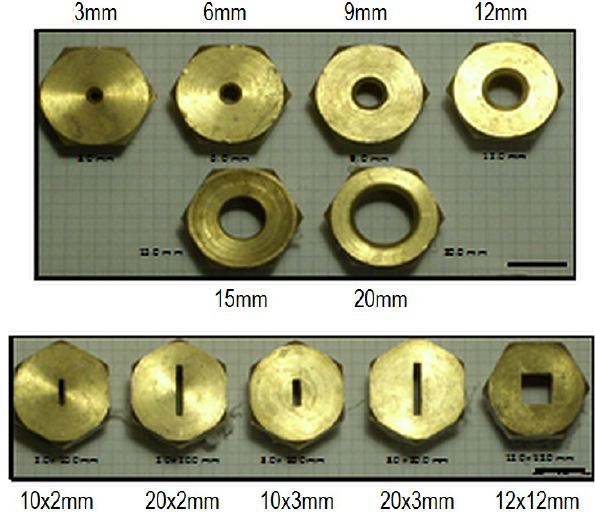
Figure 2. Test nozzles with di ff erent shape and